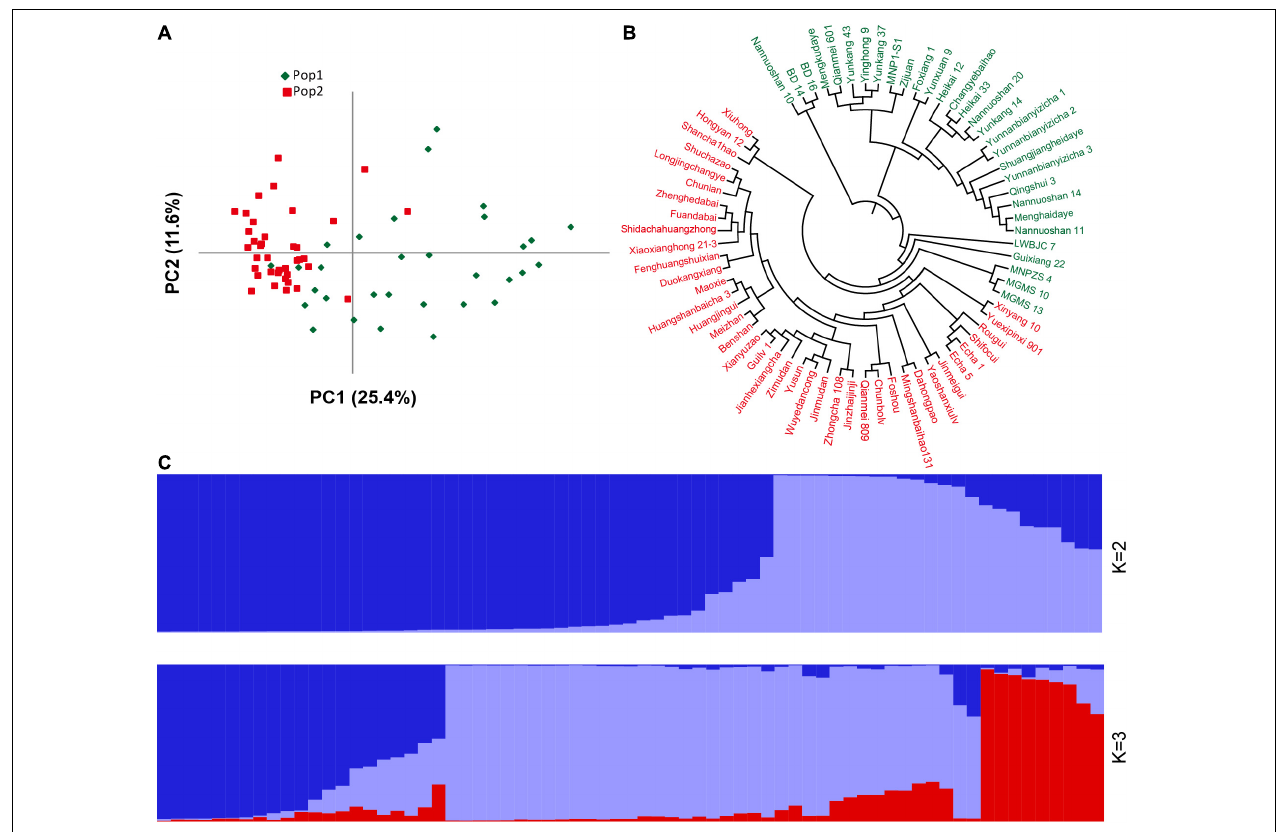
FIGURE 6 | Population structure and phylogenetic analyses of 69 germplasm samples based on the newly developed indel markers. (A) PCA analysis. (B) UPGMA phylogenetic tree. (C) Population stratification. For (A-B) , green represents Pop1, red represents Pop2, and for (C) , different colors represent different population